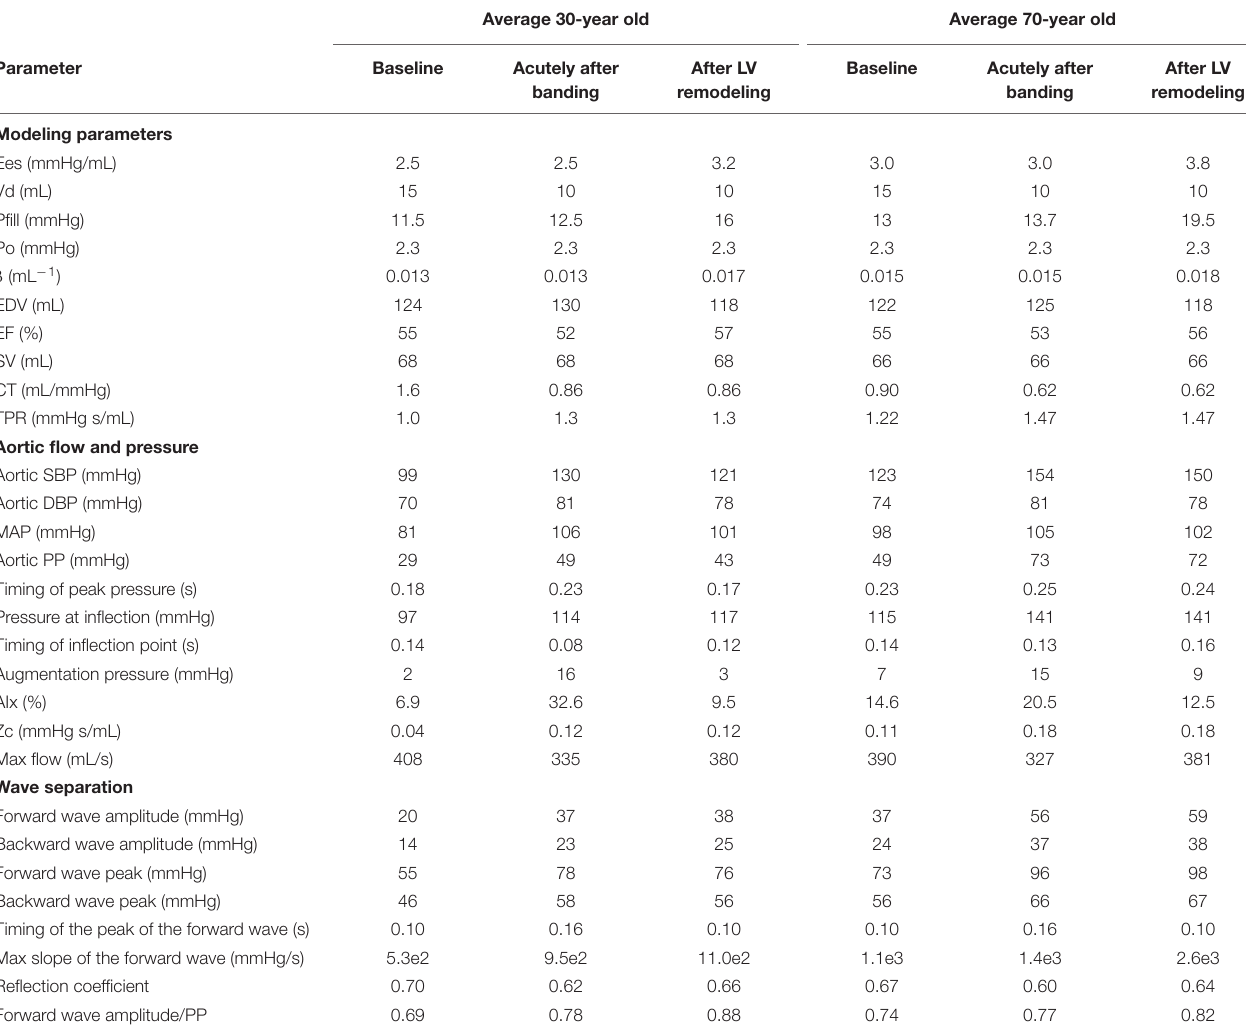
TABLE 4 | Simulation results for a young and old adult for baseline, acutely after banding and after LV